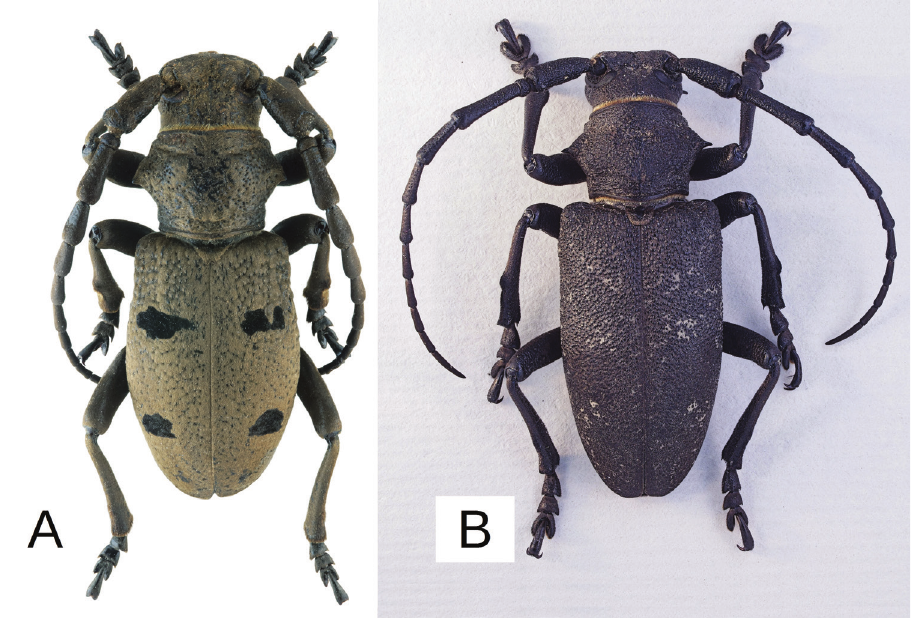
Figure 5. A Herophila tristis (Photo by Michal Hoskovec) B Lamia textor (Photo by Federico